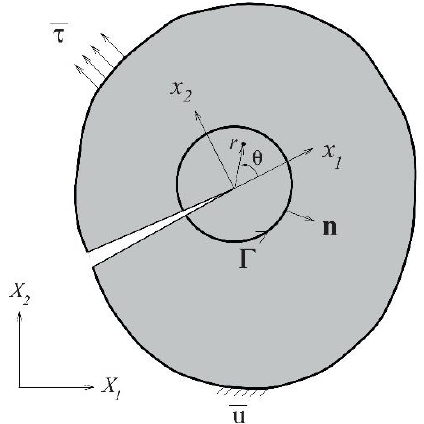
Figure 1. Coordinate system and integration path, u denotes prescribed displacement and  denotes prescribed tractions[30]